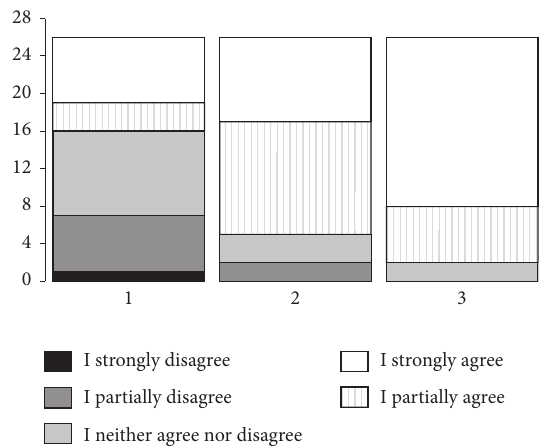
Figure 1: Detailed opinions of the participants related to following statements: (1) The robot should be a companion of the elderly person. (2) The robot should be an assistant of the elderly person. (3) The robot should be a useful device of the elderly person (something to be used when needed, with no other